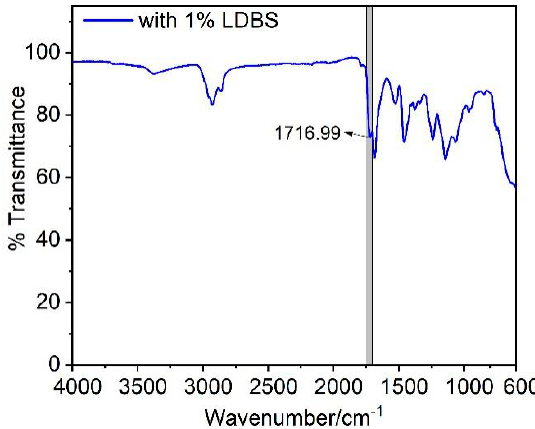
Figure 7. Integral area of the urea carbon’s characteristic peak of the blank sample. Polymers 2020 , 12 , x FOR PEER REVIEW 10 of 13